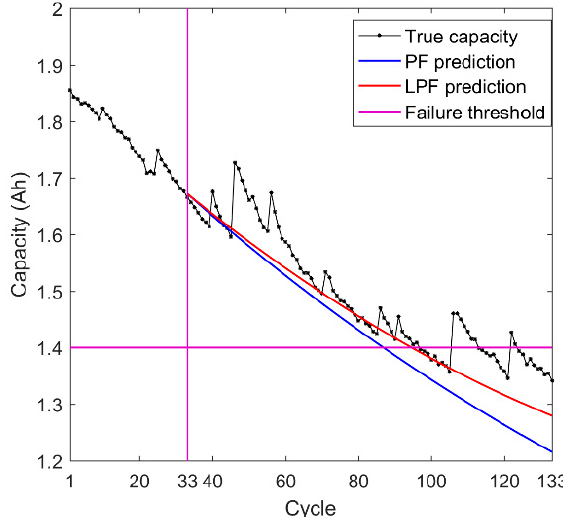
Figure 6. Prediction comparison using 33 cycles for battery B18 of a remaining useful life (RUL) of 97 cycles.